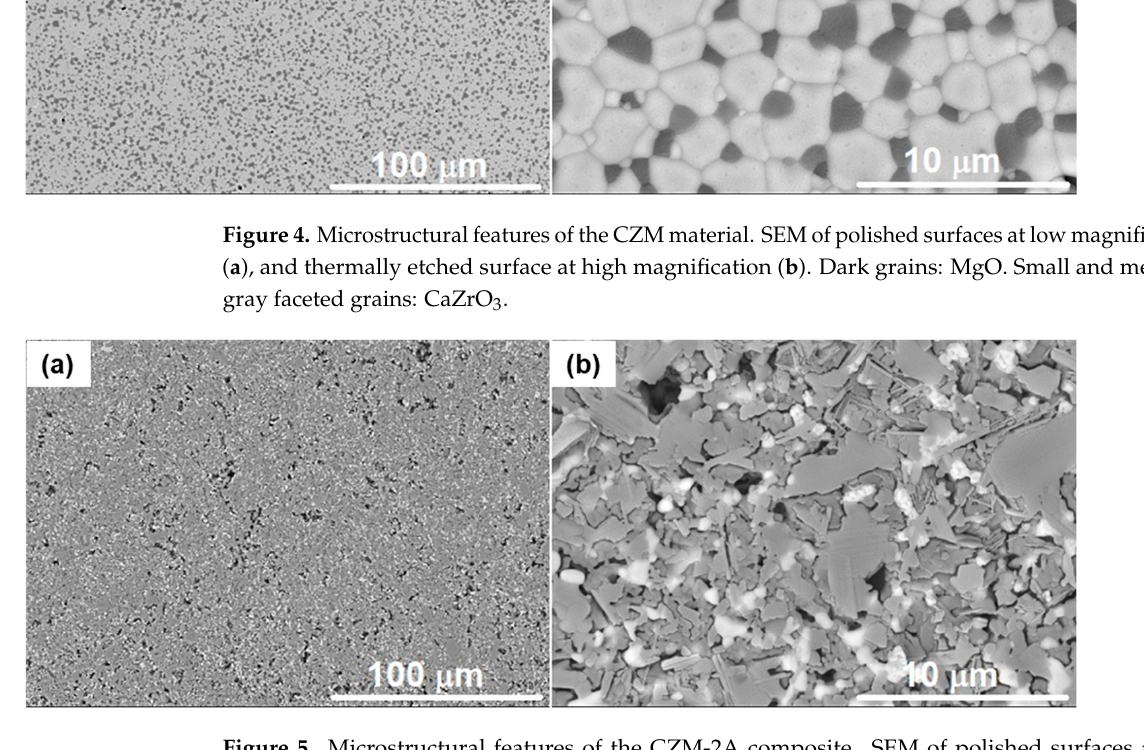
Figure 5. Microstructural features of the CZM-2A composite. SEM of polished surfaces at low magnification ( a ), and thermally etched surface at high magnification ( b ). Large pores of irregular shape are observed. White small grains: CaZrO 3 . Gray larger grains: Al 2 O 3 . Thin elongated lamellae: MgAl 2 O 4 .